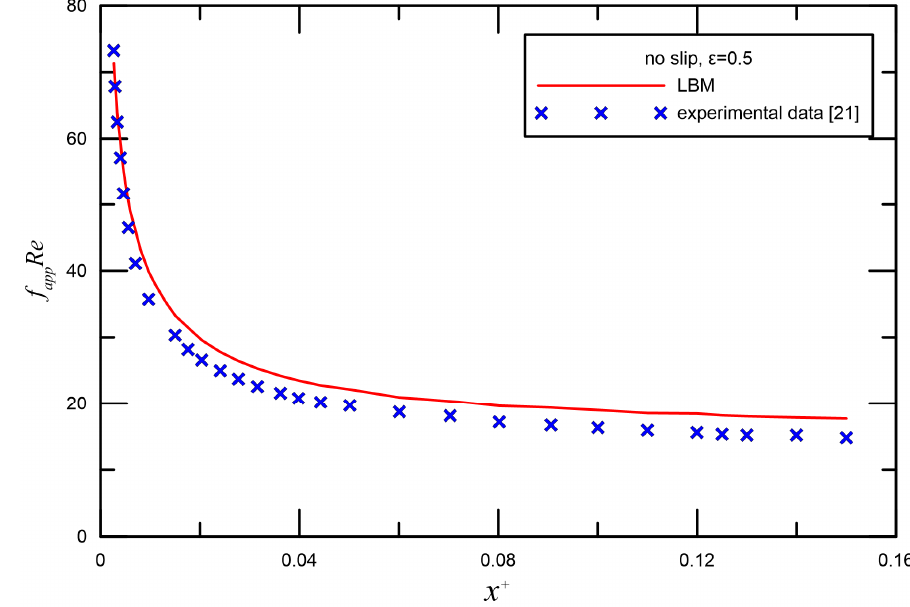
f Re Re f at the aspect ratio of 0.5 ( 0 Kn → ). Figure 6. Comparison of f app Re at the aspect ratio of 0.5 ( Kn → app app